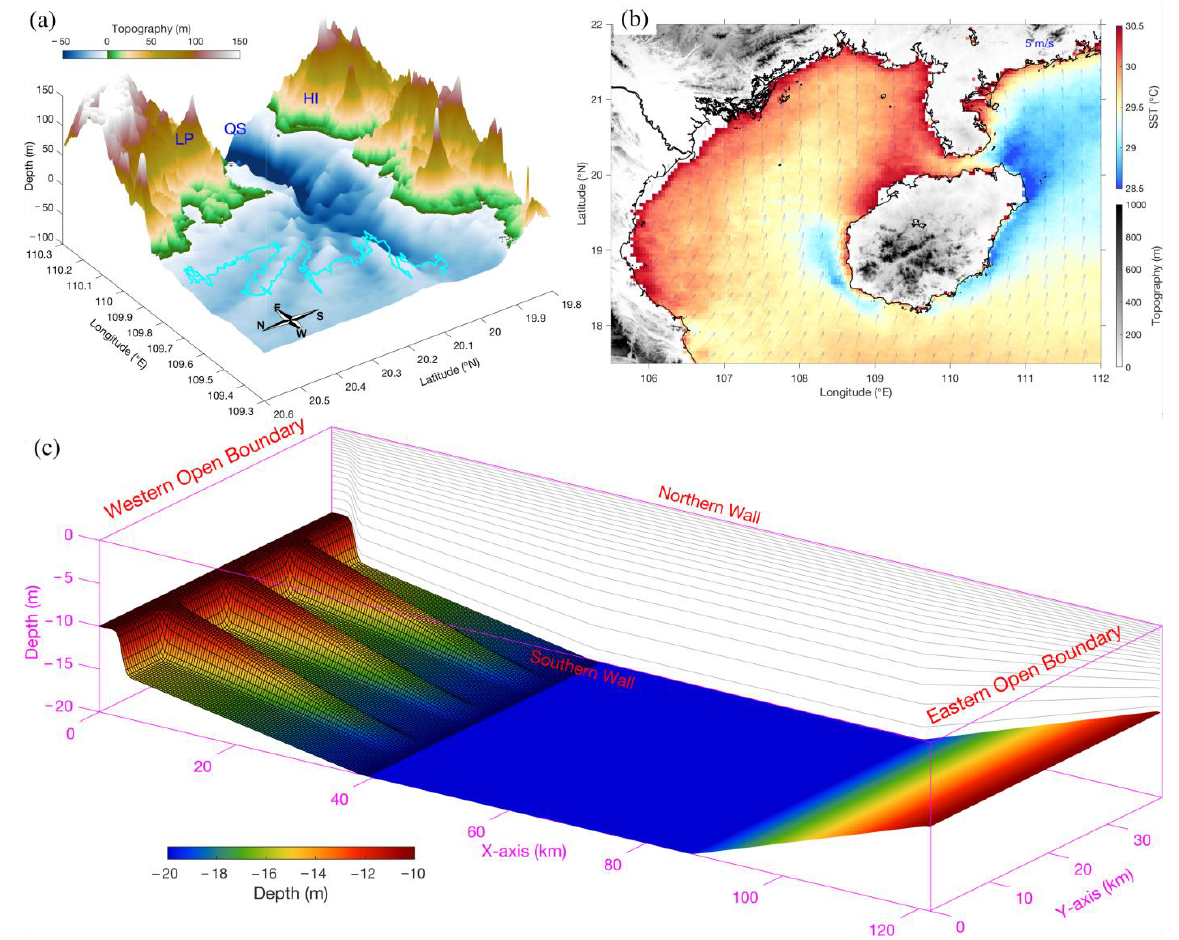
Figure 12. ( a ) Three-dimensional view of the topography over the western entrance area of the QS. Cyan contours are the same as that in Figure 3c (isotherm). ( b ) Climatological summer SST and wind around Hainan Island, the SST is derived from MODIS monthly-mean SST data and averaged over June – August 2000 – 2014, the wind is based on the ERA-Interim 3 h wind product and averaged over June – August 1979 – 2014. ( c ) The grid design of the idealized numerical experiments. Taking the key topographic features of the QS into consideration, we first designed a cuboid modeling grid, of which the length and width are consistent with that of the QS (Figure 12c). The eastern and western boundaries of the modeling domain are open, while the remaining ones are closed. The most vital design of the grid lies in the alternatively deep-shallow water depth near the western boundary. Then, based on the above analyses, vertically homogeneous 31 °C water was added to the western boundary and 28 °C water was added to the eastern side. To reflect the periodic tidal current in the strait, a 1.5 m/s